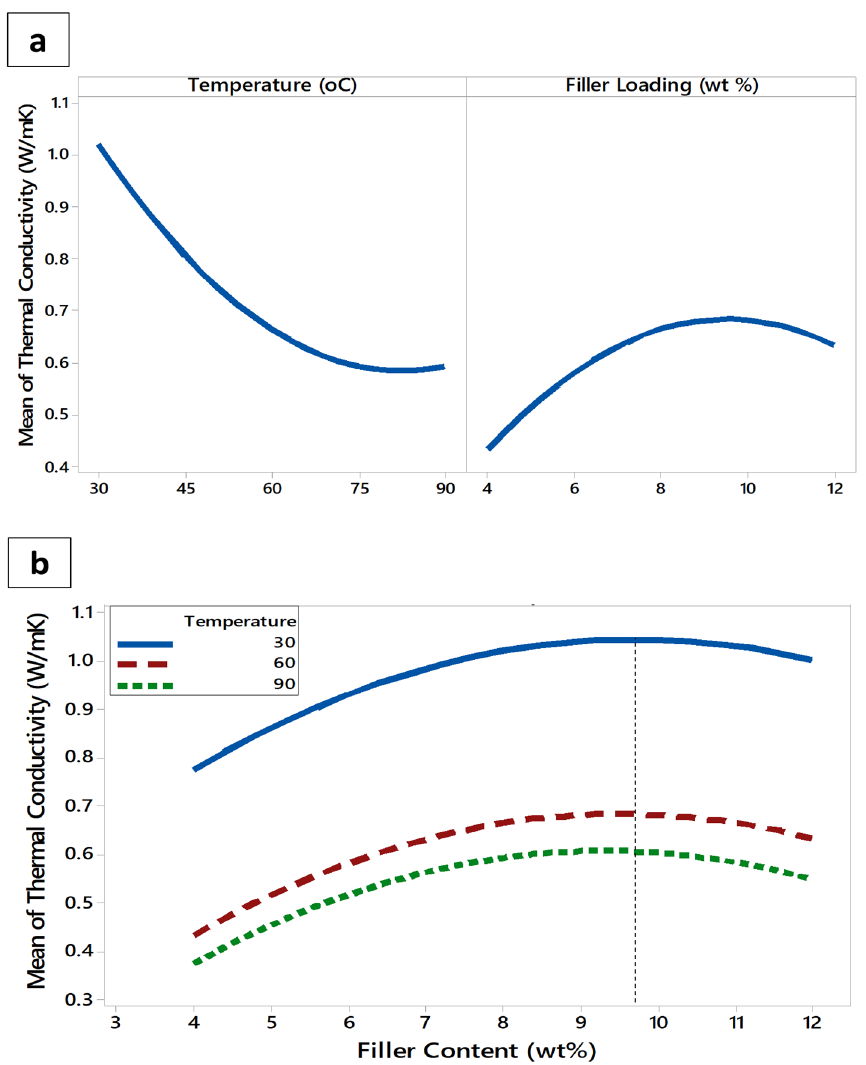
Figure 6. ( a ) Main and ( b ) interaction effect plots for the thermal conductivity of the